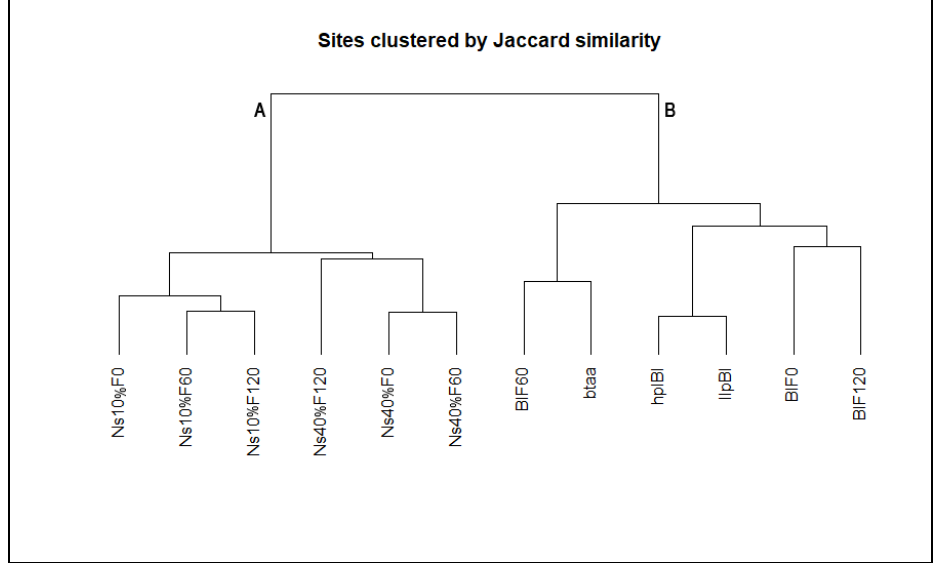
Figure 5. The Jaccard similarity computed for the results obtained by the Shannon diversity index.